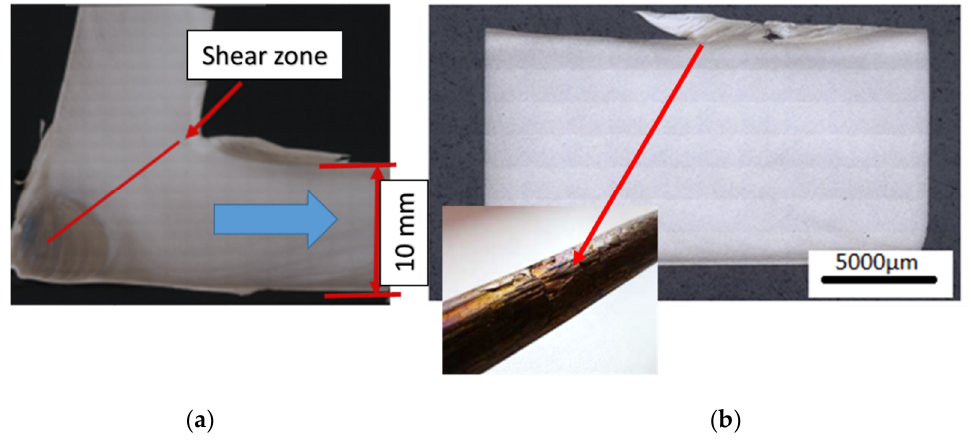
Figure 5. ( a ) Sample from the forming chamber, ( b ) deformed workpiece with detail of the top area in longitudinal direction.